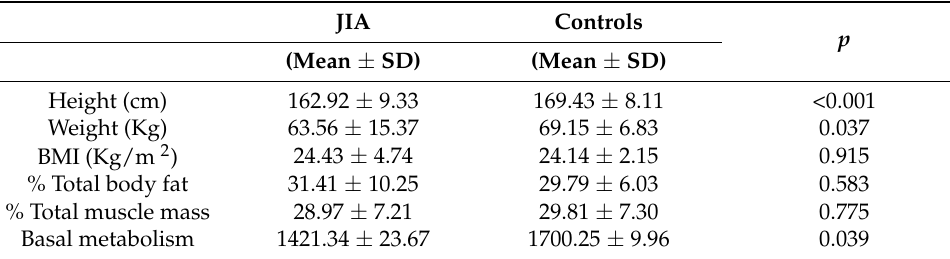
Table 2. Comparison of means of body composition in JIA patients and controls. JIA